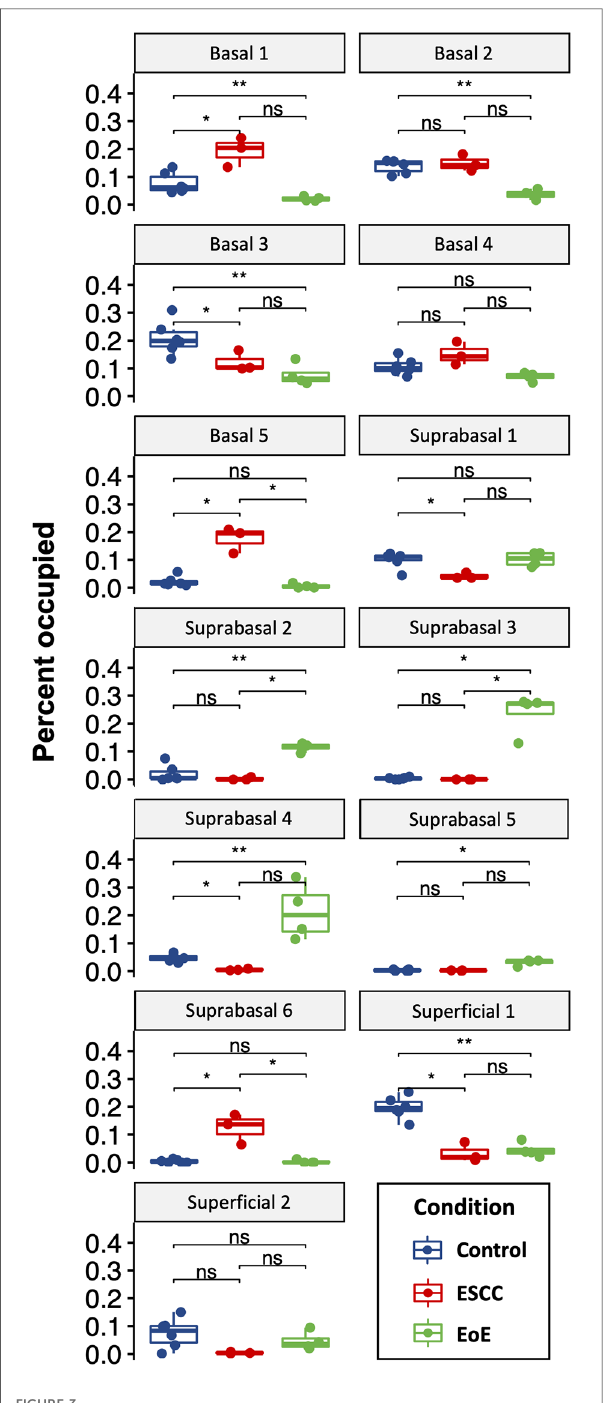
FIGURE 3 Effects of eosinophilic esophagitis (EoE) and esophageal squamous cell carcinoma (ESCC) on representation of esophageal epithelial cell populations. Proportion of each cell as a fraction of all cells in the single cell RNA-Sequencing dataset with blue indicating control mice, red indicating mice with ESCC, and green indicating mice with EoE. Each individual scatter point represents proportion indicated per biological replicate, box indicates quartiles, whiskers indicate minima and maxima. Mean is indicated by line striking through box. *, p < 0.05; **, p <0.01; ***, p <0.001 by Wilcoxon signed-ranked test with adjustment for multiple